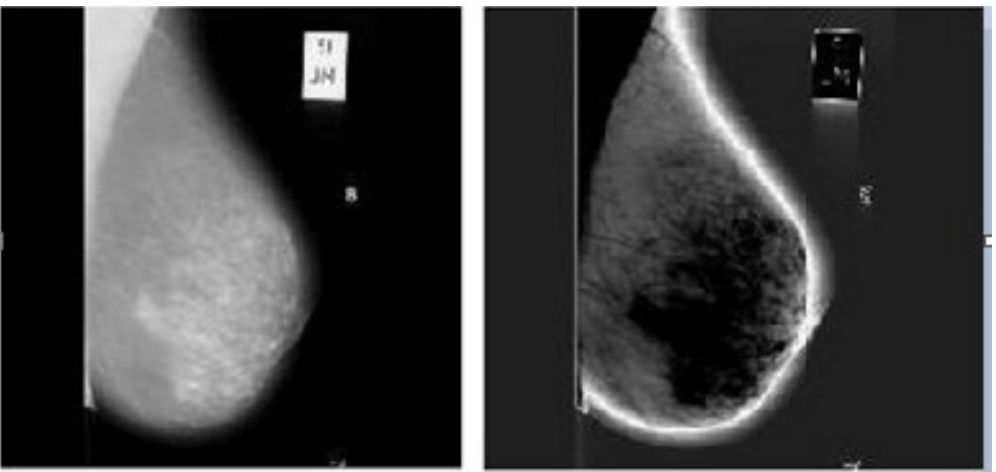
Figure 4. ( left ) Selected Input Image ( right ) Smoothened Image.